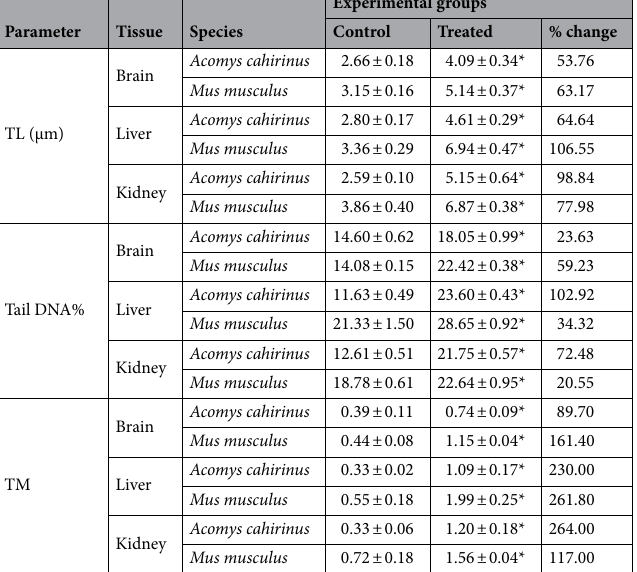
Table 1. Comet assay parameters analyzed in the brain, liver, and kidneys of Acomys cahirinus and Mus musculus following single dose (400 mg/kg) of LA. Data displayed as mean ± standard error of mean. (*) represent significant differences as compared to the corresponding controls ( P < 0.05). TL tail length, TM tail